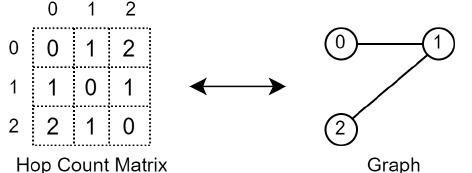
Figure 1. Example of mapping between graph and hop count matrix.